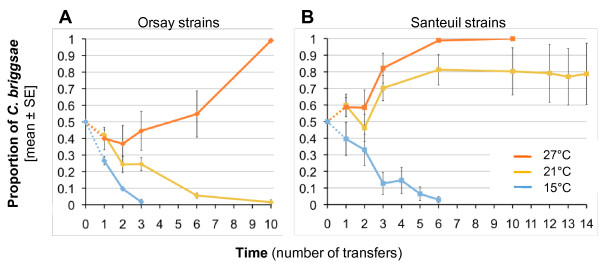
Experimental evolution of the proportion of C. briggsae individuals in competition with C. elegans at different growth temperatures. Two wild strains of C. elegans and C. briggsae from Orsay (A) or Santeuil (B) were competed against each other in the laboratory for several generations at three different temperatures (15°C, 21°C and 27°C). Starting from a frequency of 50% (ten C. elegans L4 larvae and ten C. briggsae L4 larvae), the proportion of C. briggsae individuals was quantified at different time points with five replicate populations per treatment. The mean proportion across replicates is indictaed as a thick line, and error bars indicate standard errors over replicates. Replicates are indicated as thin dotted lines. Time is represented as the number of transfers of each population to a fresh culture plate from the beginning of the experiment. For each treatment, the experiment was continued until all replicates reached fixation of either C. briggsae or C. elegans. With the Santeuil strains at 21°C, C. briggsae outcompeted C. elegans in four out of five replicates.